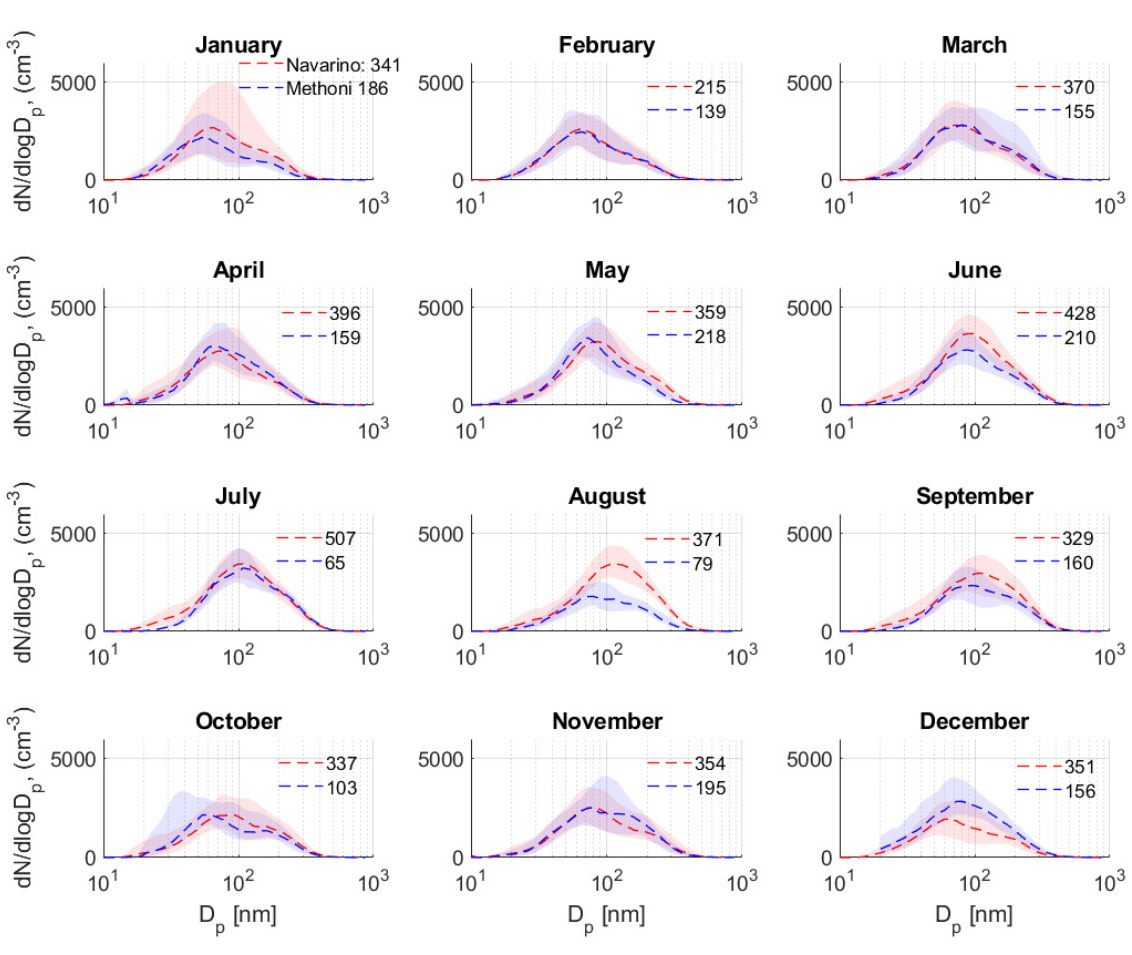
Figure 11. Monthly mean size distributions of measurements between 9 and 15 UTC at Navarino (in red) and Methoni (in blue). The numbers in each frame represents the total amount of hourly average size distributions used in the analysis.